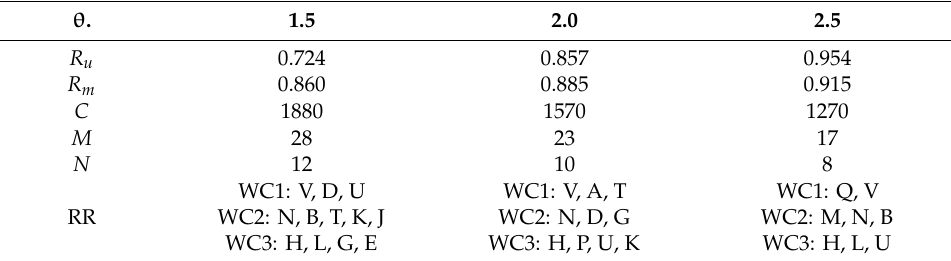
Table 7. Restoration results for di ff erent θ .